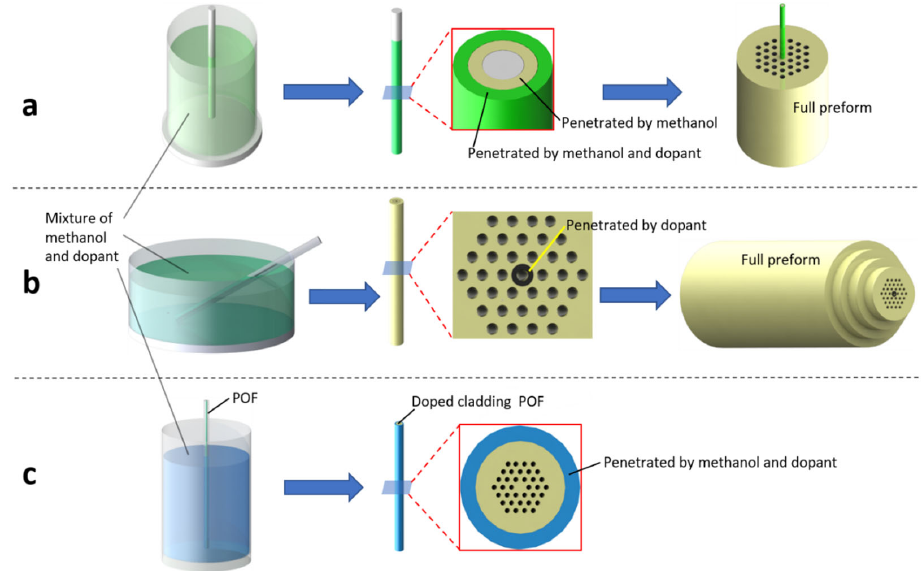
Figure 9. The fabrication process of doped mPOF by using diffusion doping technique: core preform diffusion ( a ) , central hole diffusion ( b ) , POF cladding diffusion ( c ) [33,34,42].